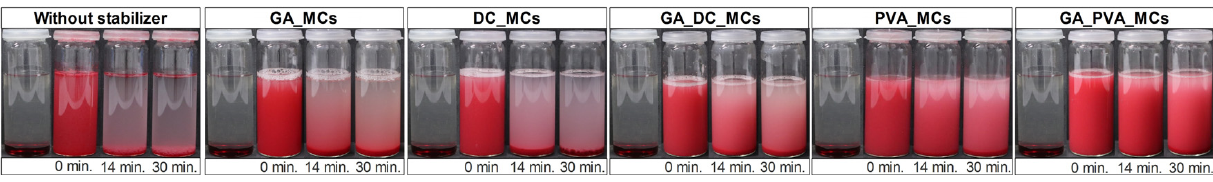
Figure 3. Evolution of the sedimentation volume fraction over time, of all the reported emulsions in study, while at rest (static conditions). After 30 min at rest, the density of droplets at the DC193 emulsion phase is significantly less than that of the GA_PVA emulsion, and the occurrence of coalescence in the sediment phase is notorious, revealing some inadequacy of the DC193 for this application (see Figure S1 from Supporting Information) All the emulsions were left to rest for 72 h and, with the exception of the DC and GA_DC_MCs’ emulsions, it was possible to obtain loose, spherical MCs (see Figure S2 from the Supporting Information). The emulsions were also followed by optical microscopy during the first 25 min of the MCs´ synthesis procedure (dynamic conditions). As was observed for static conditions, the emulsion stabilized by DC193 was the only one suffering from coalescence, with no major changes reported with the other stabilizing systems (see Figure S3 from the Supporting Information). All the stabilization systems in study led to loose MCs, with a core–shell morphology (Figure 4) and a spherical shape, except for DC193 which led to some irregular-shaped MCs and debris. The MCs show some roughness, or buckling, which is usually attributed to fluid-induced shear forces related to the mechanical stirring during the synthesis, and the inhomogeneous formation of the MCs shell due to different reaction kinetics of the isocyanate with the active H sources and water. A slow shell formation, which leads to an initially thin and flexible shell that precedes the reduction of the MCs size, due to the progress of the interfacial polymerization reactions, may also contribute to this effect. [32– 34]. The combining effect of GA and DC193 (at a 4:1 ratio) led to the smallest MCs. We believe that both the strong steric effect of the GA, due to the entropy caused by the GA branched polysaccharides hydrophilic chains, and the low surface tension provided by the DC193 surfactant contributed to the emulsion stabilization. It has been stated that when the two stabilizers coexist and reach an equilibrium state, the silicone surfactant preferentially migrates to the emulsion droplets interface and, only when this is at low concentrations does the GA partially adsorb [35]. Indeed, a DC193/GA ratio of ca. 1:1 was also tested, leading to bigger MCs with a broader size distribution.